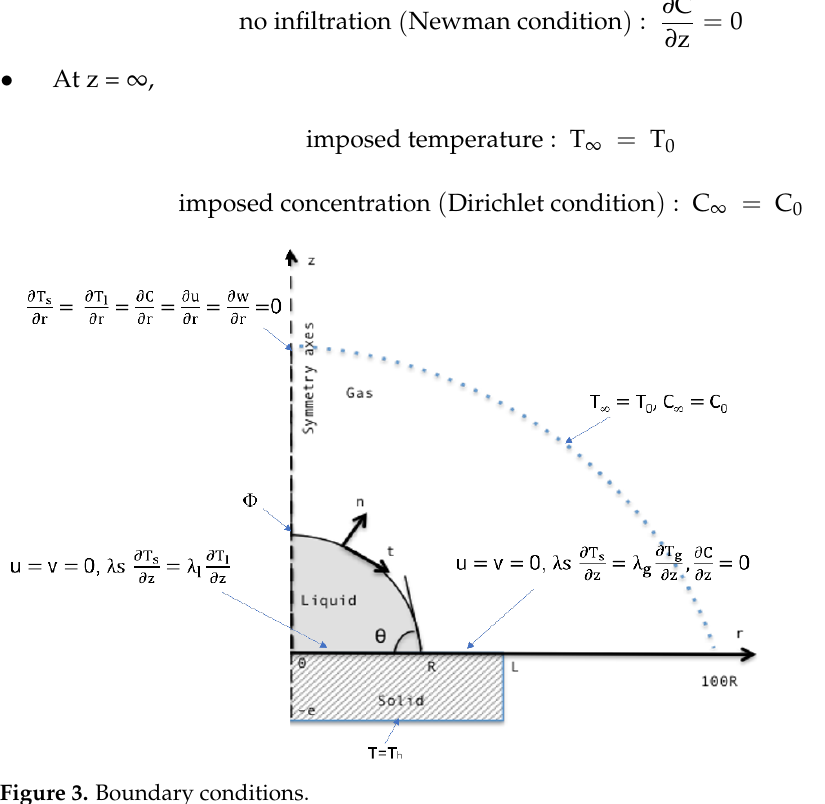
Figure 3. Boundary conditions.